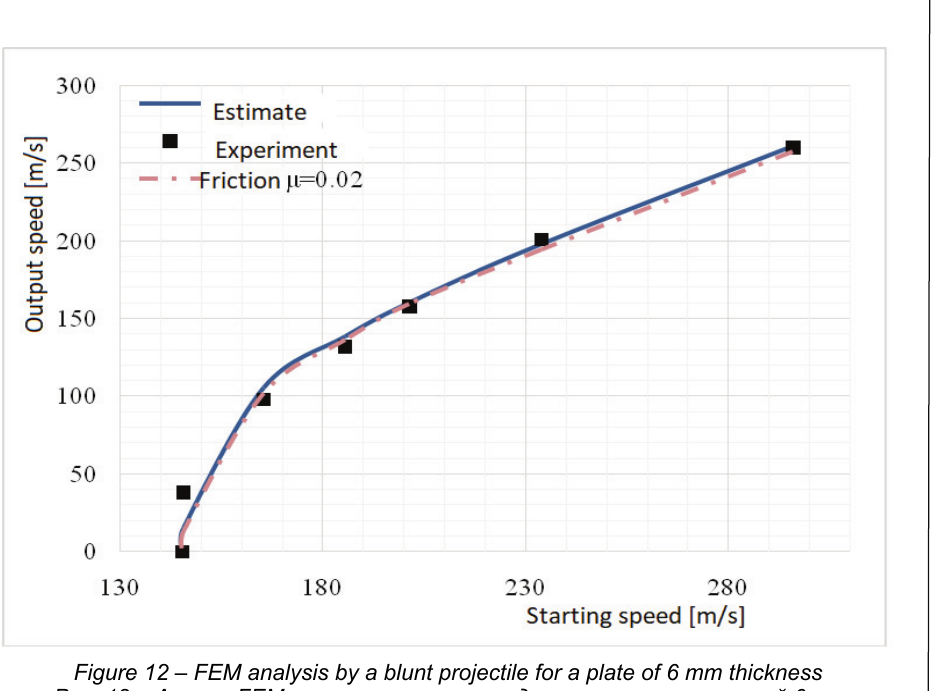
Figure 12 – FEM analysis by a blunt projectile for a plate of 6 mm thickness Рис . 12 – Анализ F Е M тупоконечным снарядом на плиту , толщиной 6 мм